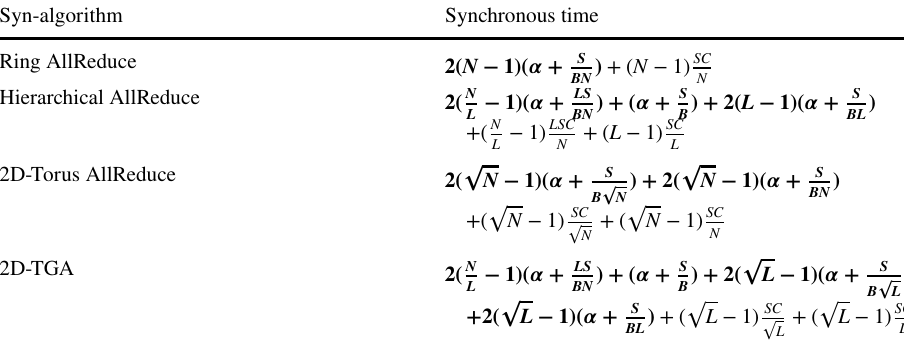
time of different algorithms